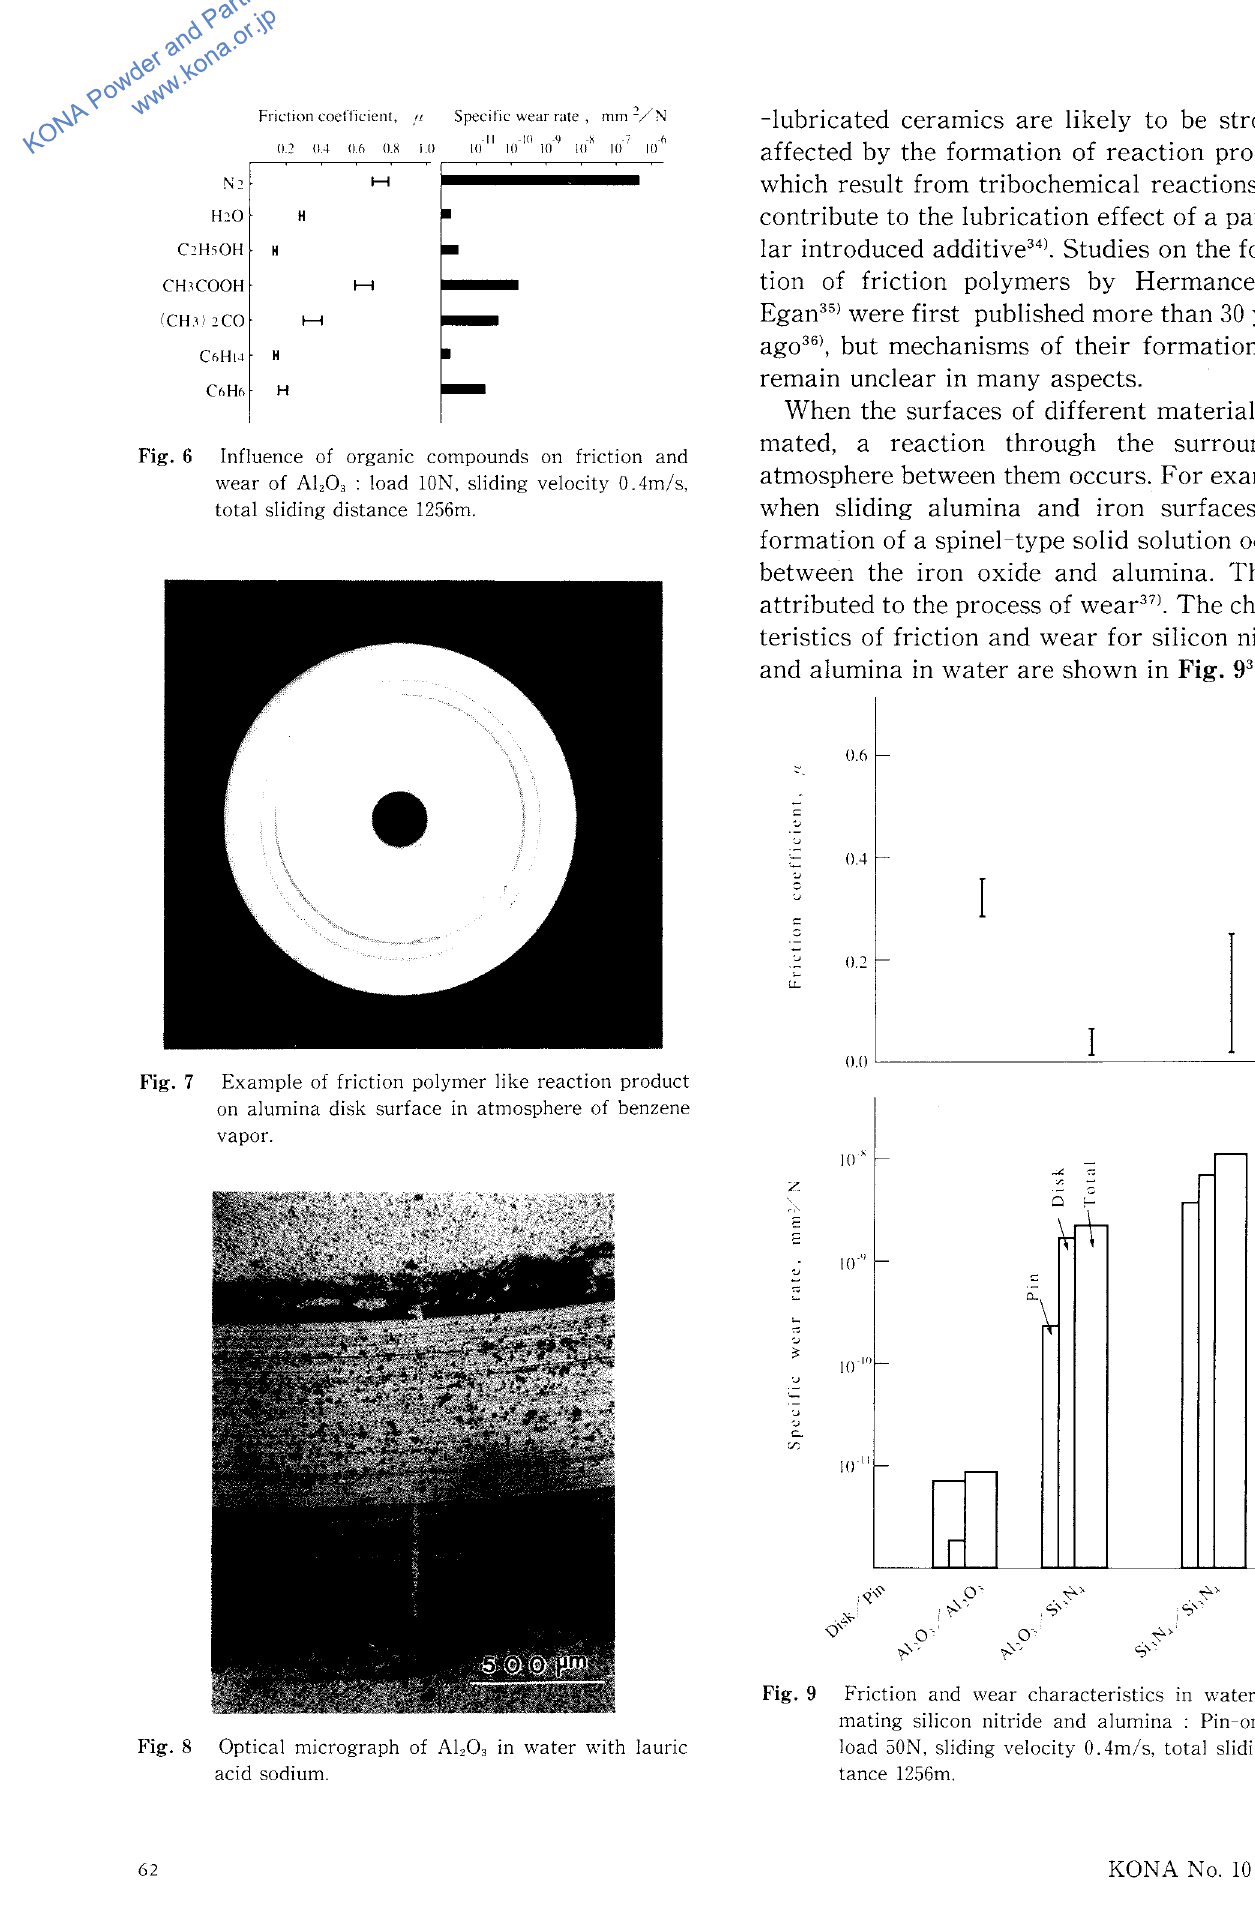
Fig. 8 Optical micrograph of Al acid sodium.